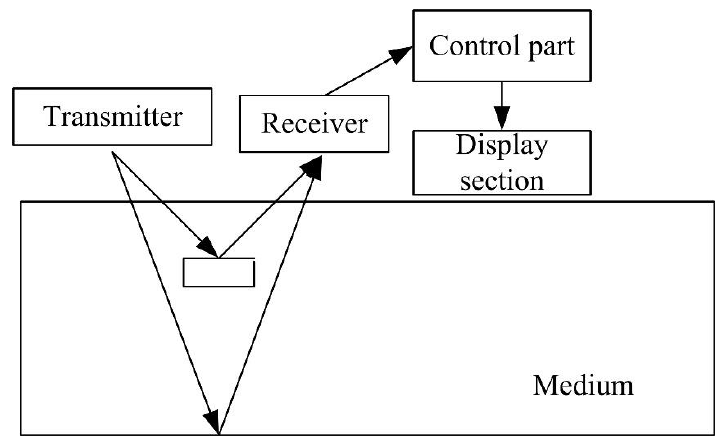
Figure 1. Work process of ground-penetrating radar (GPR).